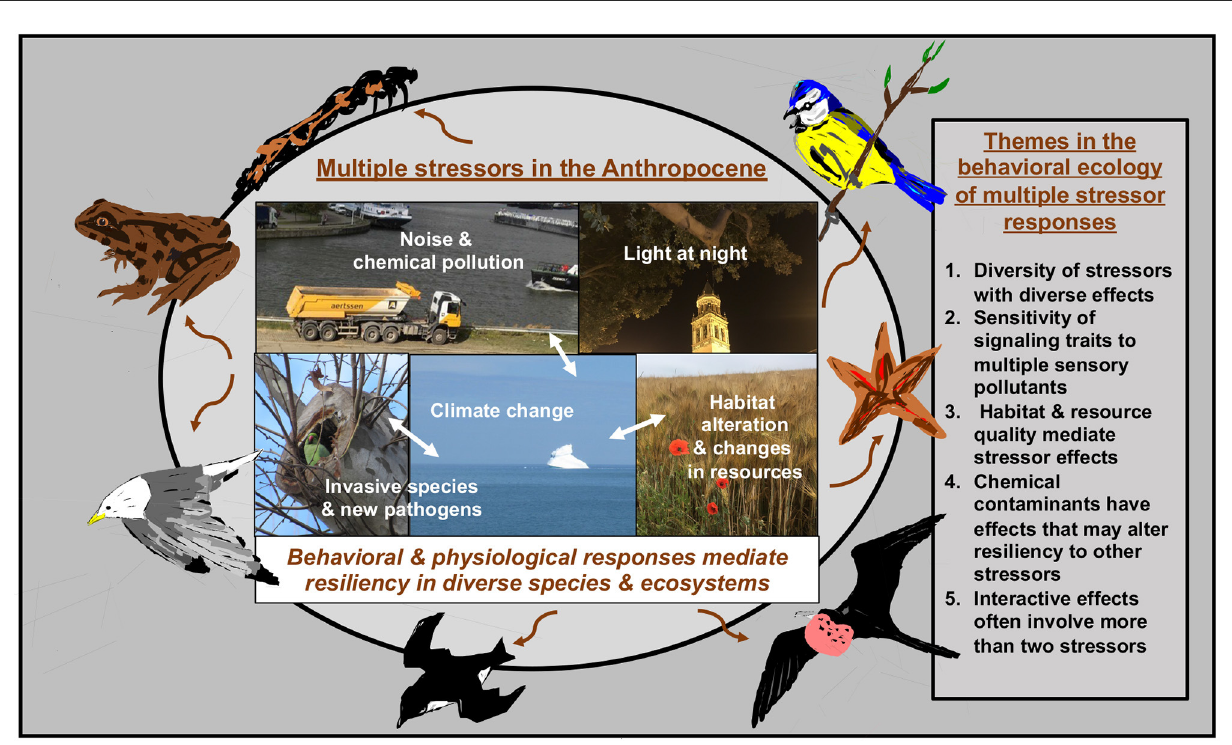
FIGURE1 Conceptual framework and central themes in the behavioral ecology of multiple stressor responses in the